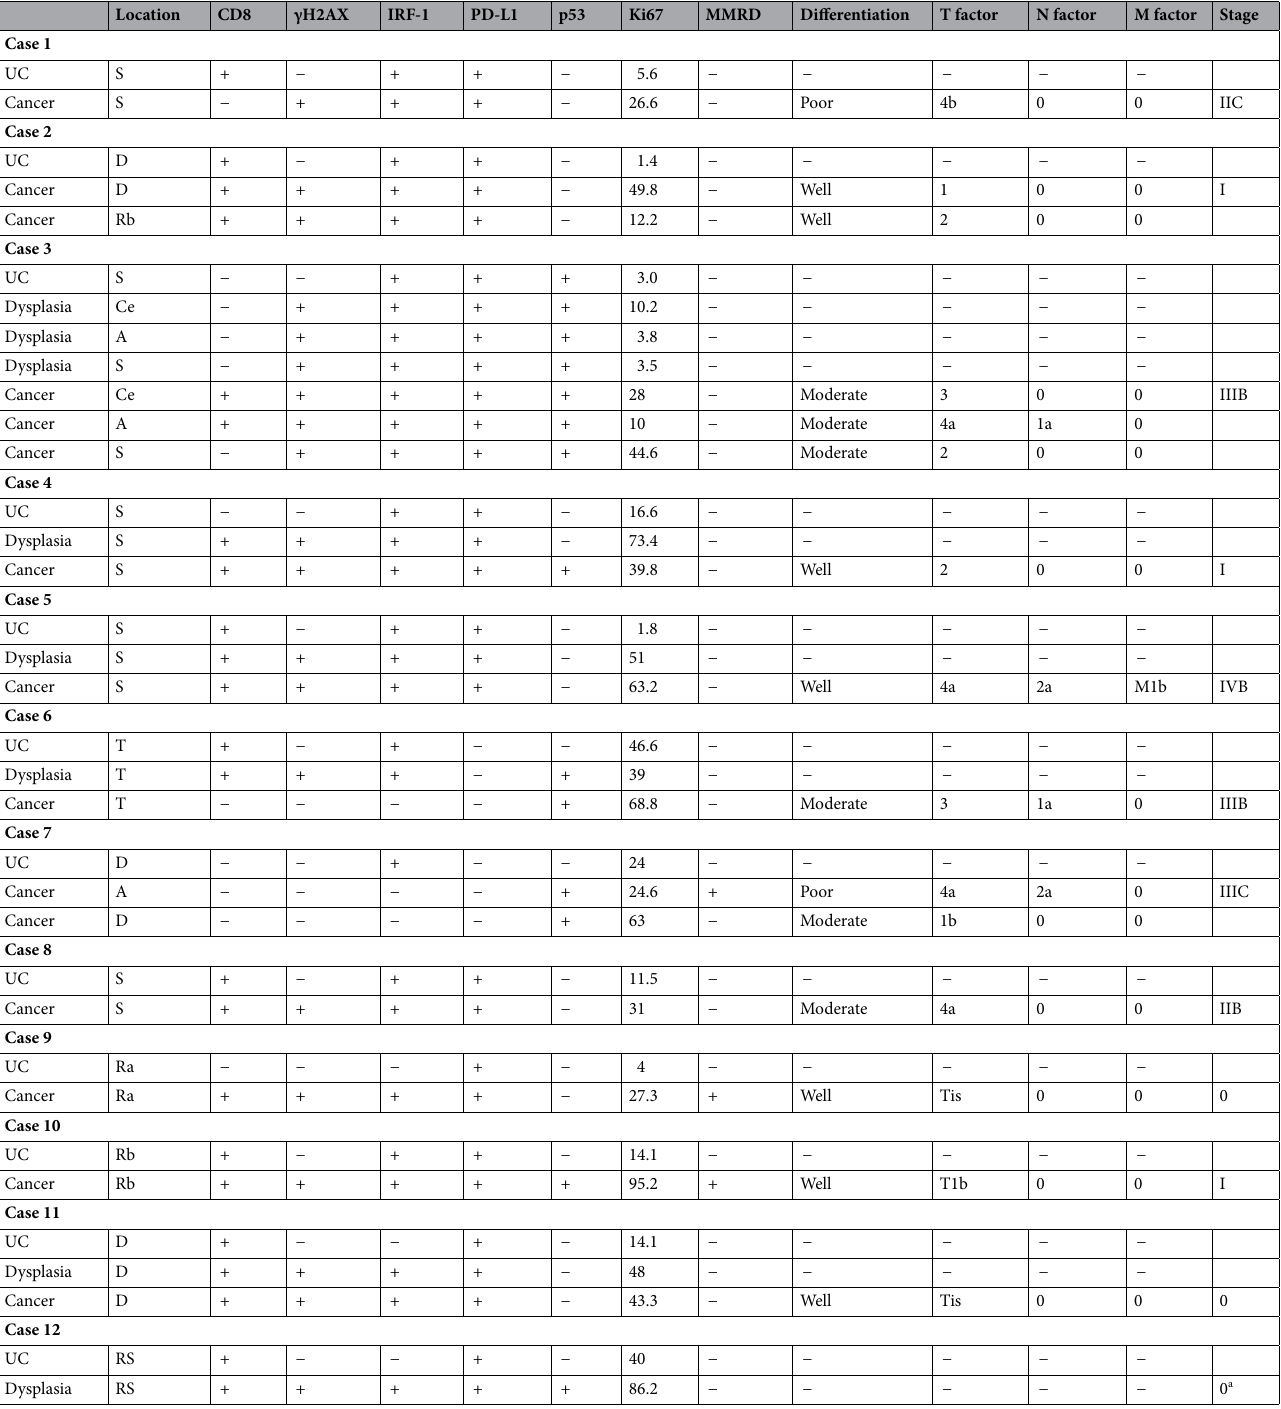
Table 5. Clinicopathological characteristics of patients with ulcerative colitis (UC) with UC-associated dysplasia/colitic cancer. Ce cecum, A ascending colon, T transverse colon, D descending colon, S sigmoid colon, RS rectosigmoid, Ra upper rectum, Rb lower rectum. + , Positive or high expression of target proteins; − , Negative or low expression of target proteins. UC indicates the corresponding noncancerous tissues in sections with dysplasia/colitic cancer. a One case with no colitic cancer and only dysplasia was included in Stage